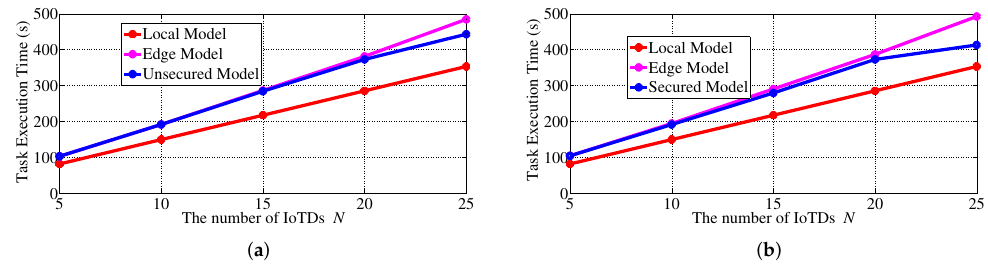
Figure 5. The task execution time. ( a ) Unsecured model; ( b ) Secured